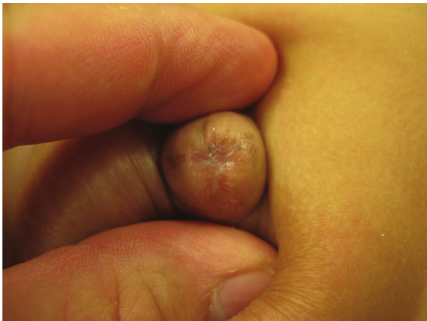
FIGURE 3: Trapped penis. This boy had a trapped penis, where a scar had formed over the penis. A conservative approach was taken, and no surgery was required. The skin now comes over the